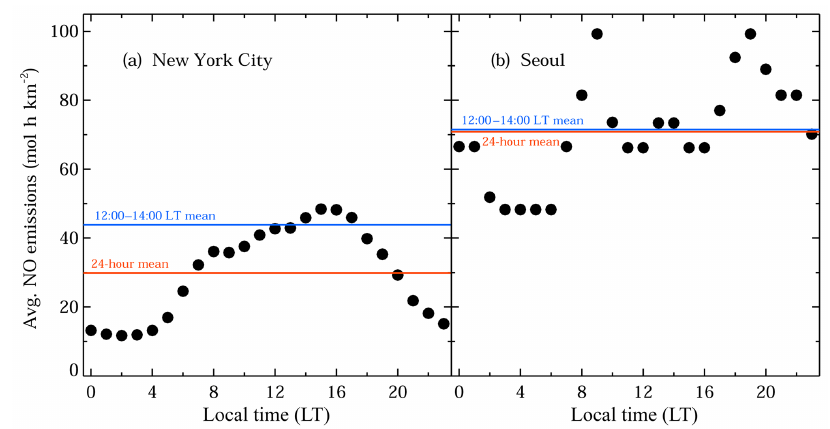
Figure 4. The diurnal profile of NO x emissions rates processed from the bottom-up inventory. (a) The diurnal profile of NO x emissions rates during a weekday in New York City during July 2011 using SMOKE as the emissions preprocessor (Goldberg et al., 2016). (b) The diurnal profile of emissions rates during a weekday in Seoul during May 2016 using EPRES as the emissions preprocessor. Emissions profiles in the right panel were used in the WRF-Chem